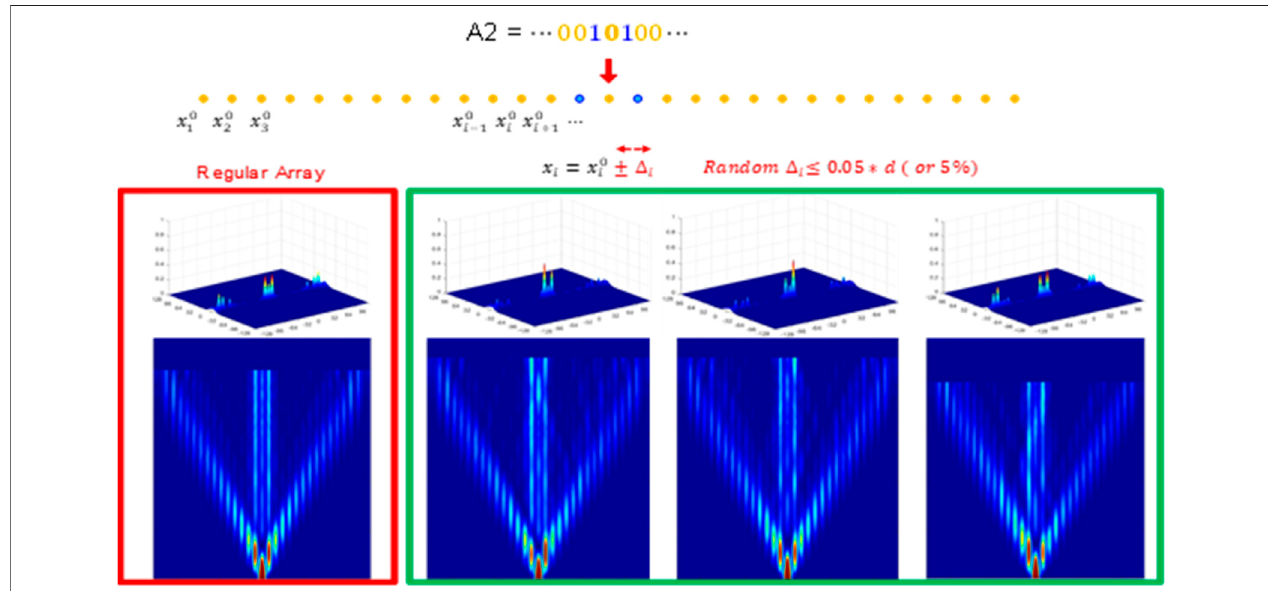
FIGURE 8 | Light propagation and photon distribution in BPL A2 of 29 cores in which cores are placed 5% randomly disordered around their ideal, regular positions.